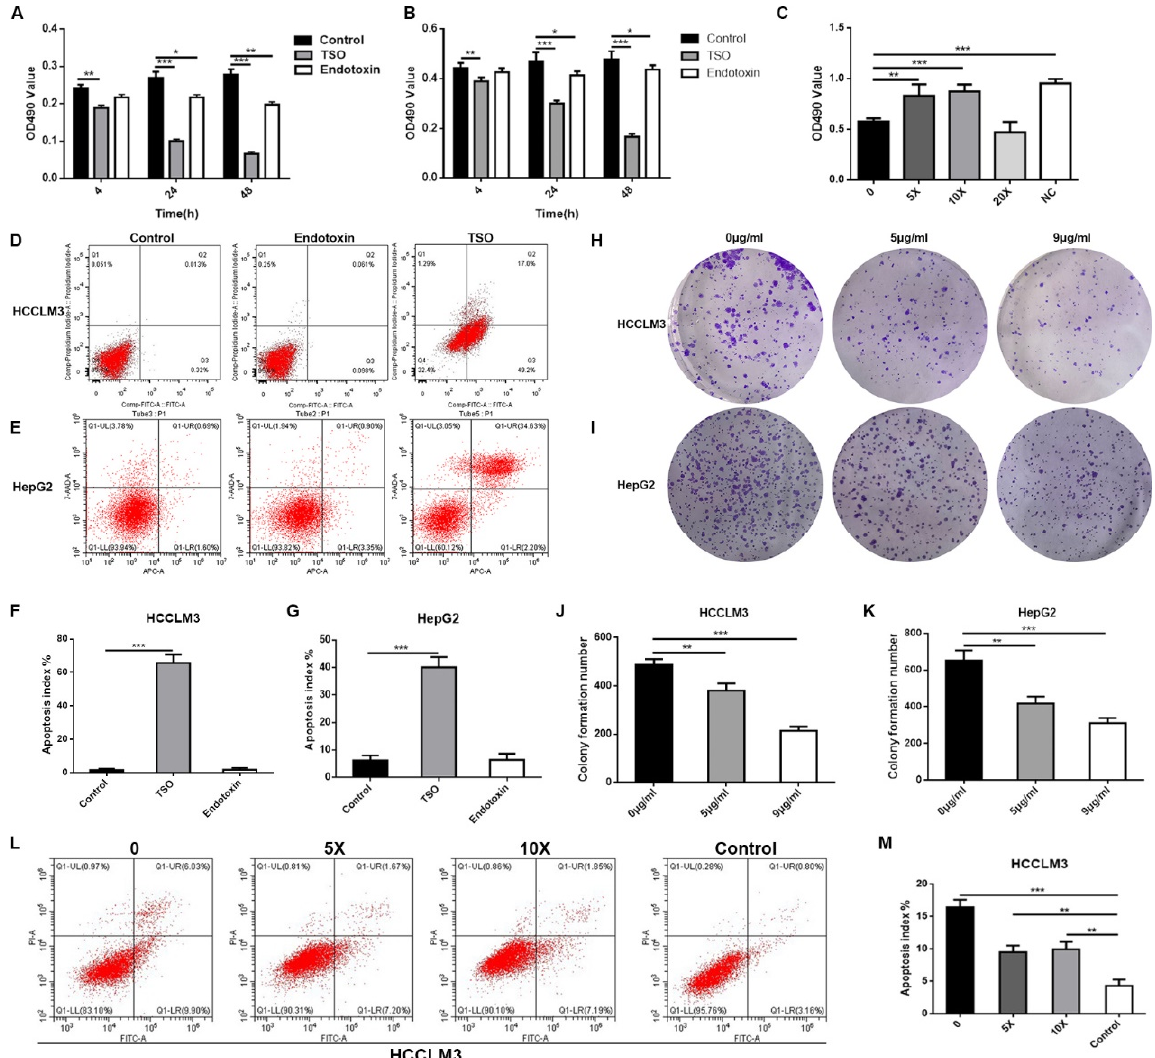
Figure 4. TSO can significantly inhibit the proliferation, migration, and invasion of HCCLM3 and HepG2 cells, and promote apoptosis. ( A ) Effect of TSO on HCCLM3 cell growth determined by CCK-8 assays. Significant inhibitory effects were observed at 4 h. ( B ) Effect of TSO on HepG2 cell growth determined by CCK-8 assays. Endotoxin showed little influence on cell growth. ( C ) DMEM medium containing 10 times as much tryptophan showed the strongest proliferation effect on HCCLM3 cells after TSO administration. Group 0 represents the medium without addition of tryptophan changed after administration. The n × group represented the medium that contained n times as much tryptophan as the original medium changed after administration. The NC group represented the unadministered group. ( D – G ) Flow cytometry results of the TSO group, endotoxin group (0.01 EU/mL), and control group. The results showed that TSO could promote the apoptosis of HCCLM3 and HepG2 cells, and that the endotoxin content at this concentration had no effect on cell growth. ( H – K ) Colony formation assays in HCCLM3 and HegG2 cells with TSO or control. ( L , M ) Flow cytometry results of groups with different tryptophan contents. The culture medium of group 0, 5 × , 10 × , and control were the same as that of Figure 4C. Data are mean ± SD, n = 5; * p < 0.05, ** p < 0.01 and *** p < 0.001 vs. Group